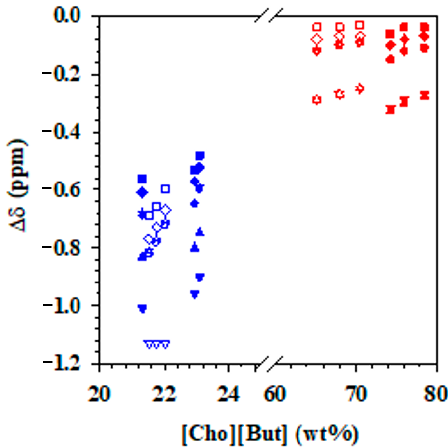
Figure 5. Chemical shift deviations of the protons in the top, [Cho][But]-rich phase (red) and the bottom, K 3 PO 4 -rich phase (blue) of the ABS with [Cho][But] and K 3 PO 4 at pH 7.2 (filled symbols) pH 14.5 (open symbols): H1 ( (cid:117) ), H2 ( (cid:72) ), H3 ( (cid:78) ), H4 ( (cid:4) ), H5 ( • ), H6 ( (cid:70) ), following the numeration and pH 14.5 (open symbols): H1 ( ◆ ), H2 ( ▼ ), H3 ( ▲ ), H4 ( ■ ), H5 ( ● ), H6 ( ★ ), following the nu- indicated in Table meration indicated in Table 3.